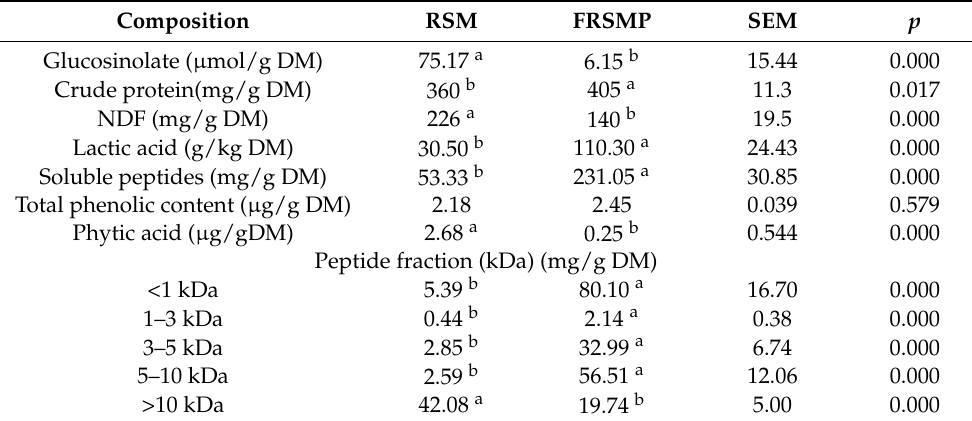
Table 2. Chemical composition and peptide fractions of the RSM and FRSMP.